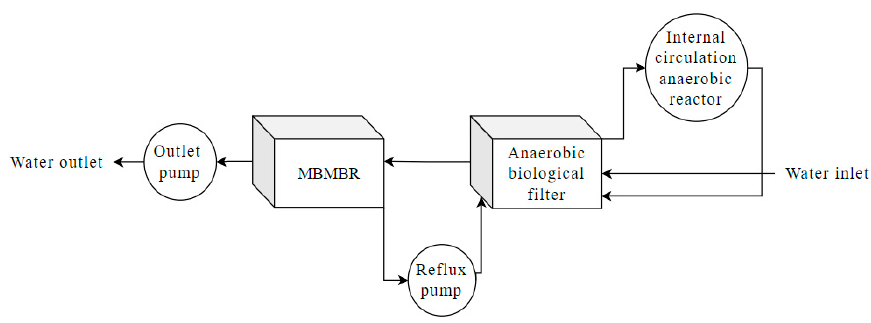
Figure 5. A hybrid treatment process of aquaculture wastewater